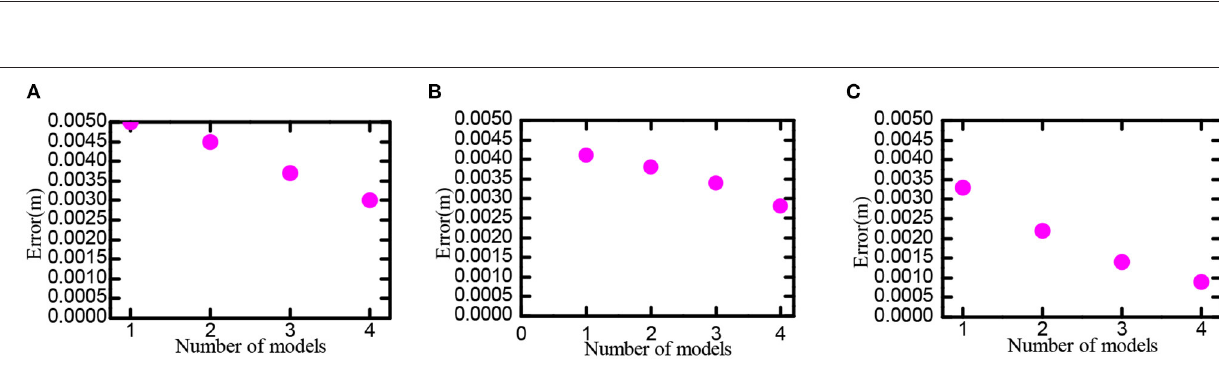
FIGURE 13 | Comparison of spatial cognition accuracy between with and without boundary cells. (A) When there is no boundary cell, the deviation between the cognitive results and the actual trajectory becomes larger and larger. (B) When touching the boundary (at the green point) the accumulated error is corrected.